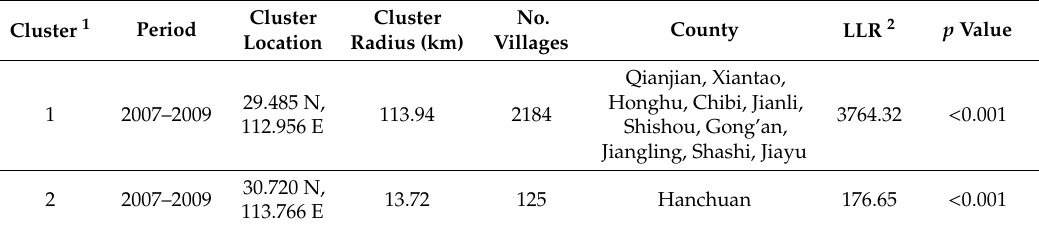
Figure 3. Mapping of significant spatiotemporal clusters of schistosomiasis RIR, by administrative village. Table 2. Significant spatiotemporal clusters of schistosomiasis RIR as defined by space–time scan statistic in the 30 most endemic counties, Hubei Province,